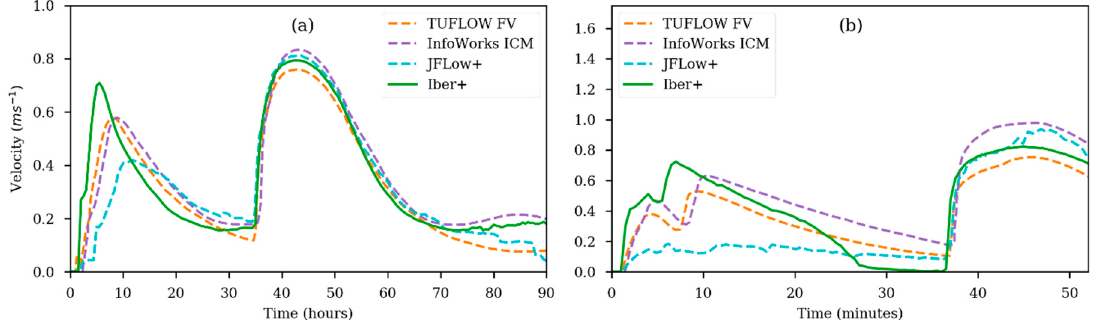
Figure 16. Time series of the velocities for Test 8A obtained with different numerical models. Measurements for Point 2 ( a ); and Point 6 ( b ).